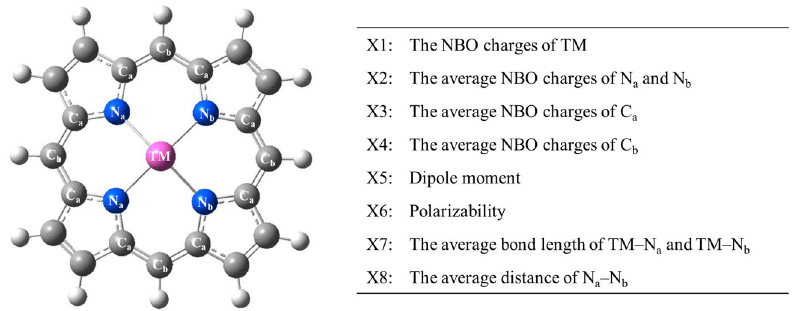
Table 1. Structural and electronic properties of transition-metal–porphyrins (TM–PPs).